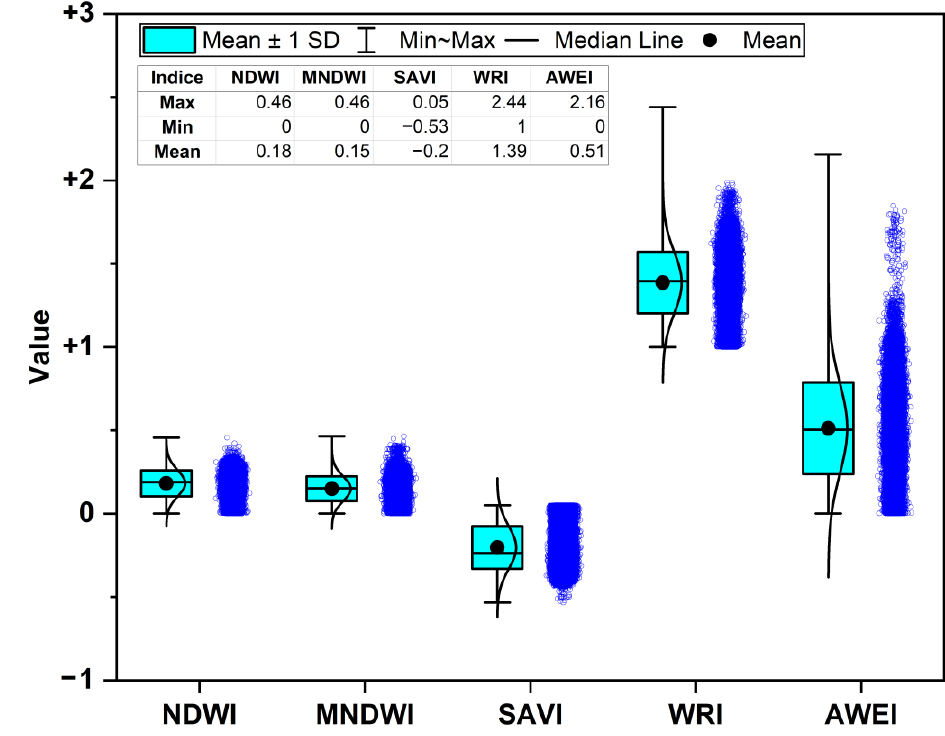
Figure 6. Box plot of water indices including their mean, maximum, and minimum values repre- sented as waterbody. as